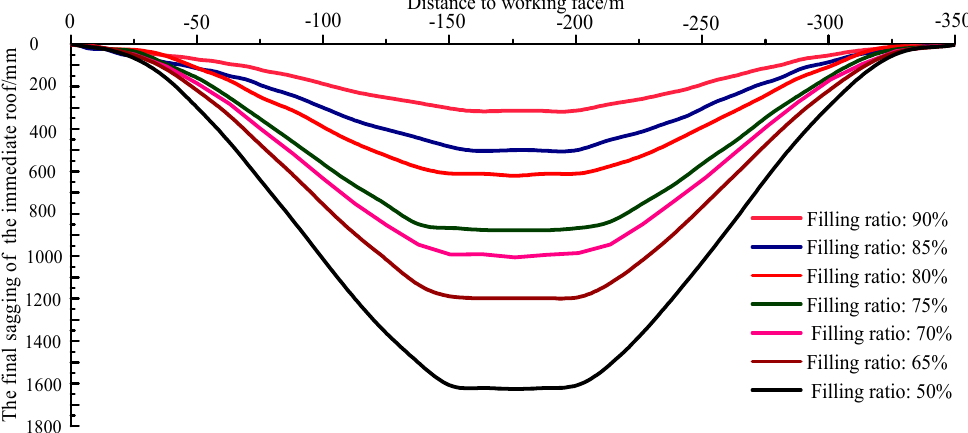
Figure 9. The final sagging curves of the immediate roof with different filling ratios.